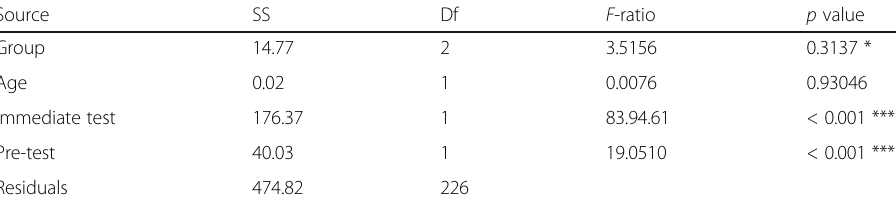
Table 7 Analysis of variance (ANOVA) type II result for immediate test, delayed test, and pre-test Source SS Df F